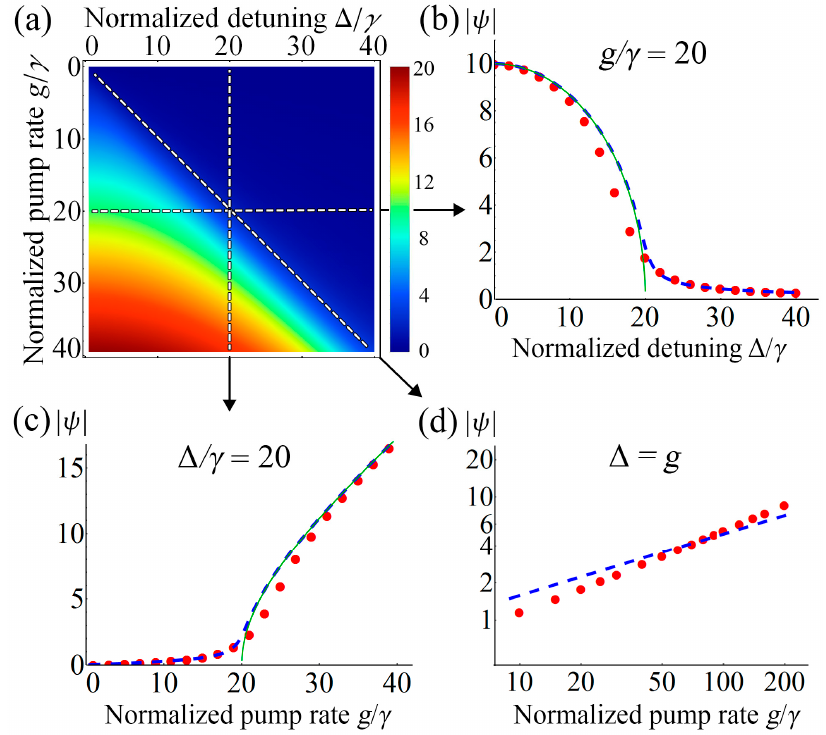
Figure 3. ( a ) Phase diagram of the modulus of anomalous average | ψ | as a function of the frequency detuning Δ and the pump rate g in units of the two-photon dissipation rate γ . The color plot is computed from the numerical solution of the Lindblad master equation on a truncated Fock basis. ( b , c ) Corresponding cross-sections at a fixed value of the pump rate g/ γ = 20 ( b ) and frequency detuning Δ / γ = 20 ( c ). ( d ) Double logarithmic plot of the modulus of anomalous average | ψ | vs pump rate g at the critical point Δ = g for g >> γ . The calculation was carried out by numerical simulation of the master equation (red dots) and from the mean-field analytic solution (19) (blue dashed line), as well as from the semiclassical approximation (18) (green curve).